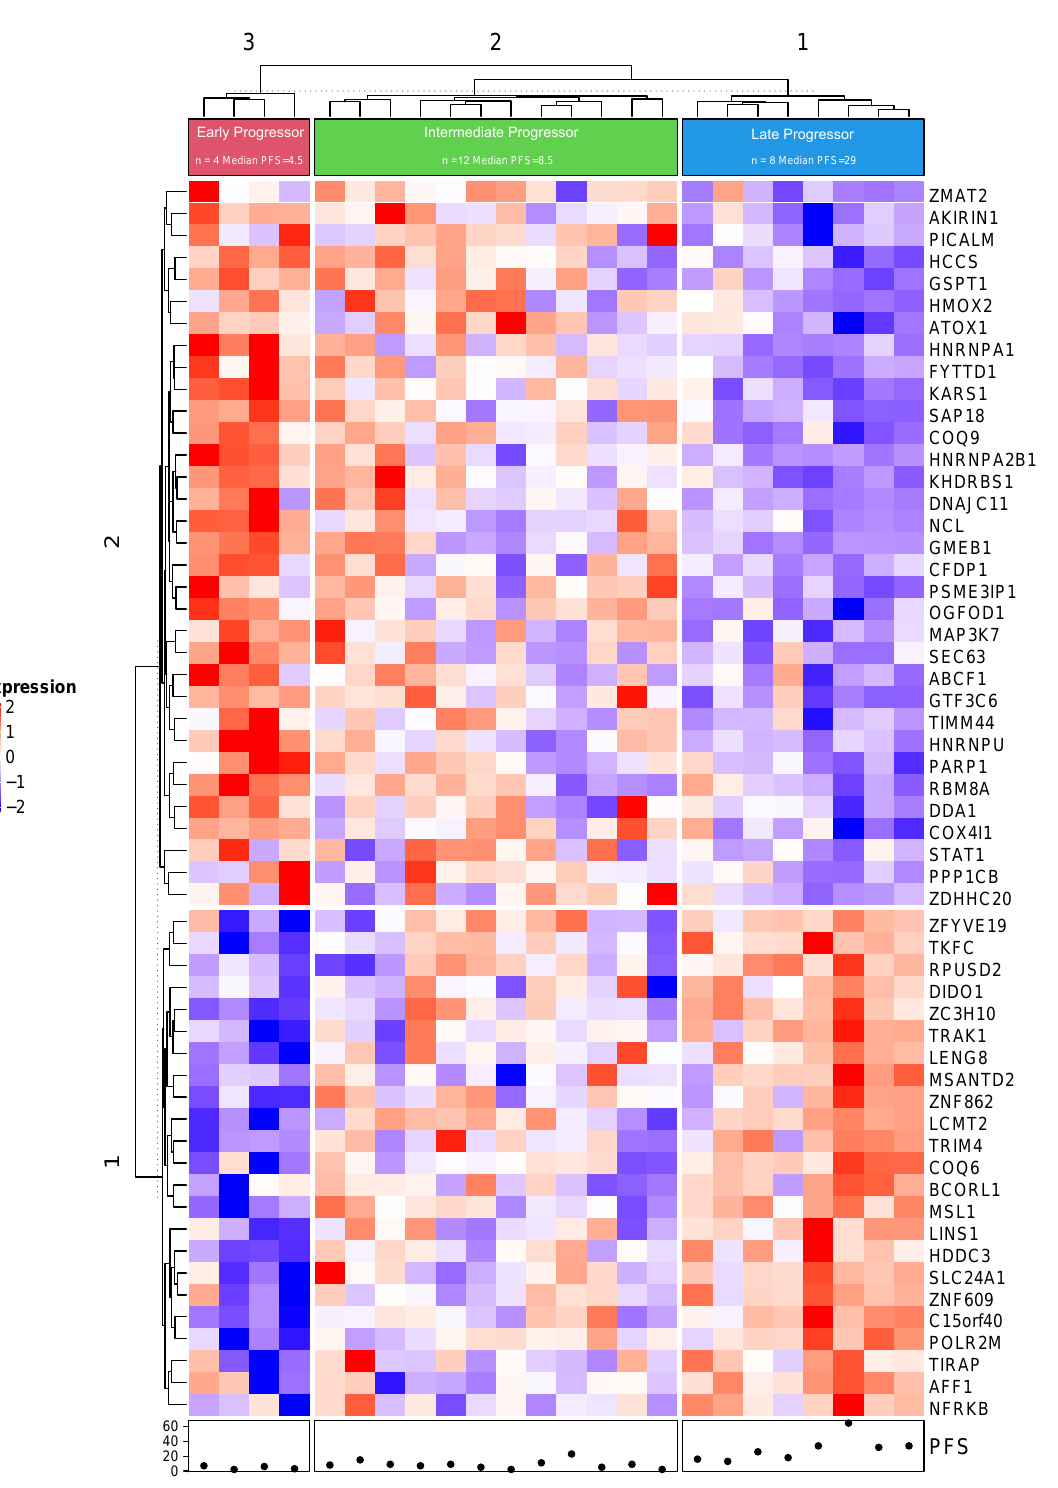
Figure 2. Differential gene expression. Whole transcriptome RNAseq was available for 24 (22%) patients with 0–1 prior line of therapy, and 56 genes were selected with HR ≥ 4 or HR ≤ 0.25 and FDR ≤ 0.15. The differential gene expression of all coding gene fragments per kilobase of exon per mil- lion (FPKM) mapped fragments were mapped in patients with continuous progression-free survival (N = 29) (cluster 3 (N = 4) median PFS = 4.5 months; cluster 2 (N = 12) median PFS = 8.5 months; and cluster 1 (N = 8) median PFS = 29 months). PFS is shown below the heat map (range 1,